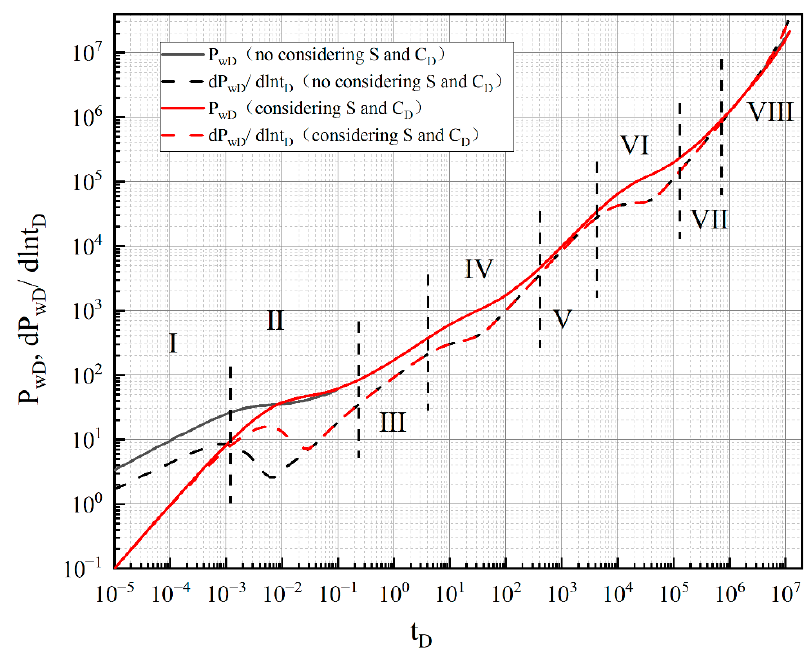
Figure 4. Pressure response of a multi-fractured horizontal well in a volcanic reservoir.